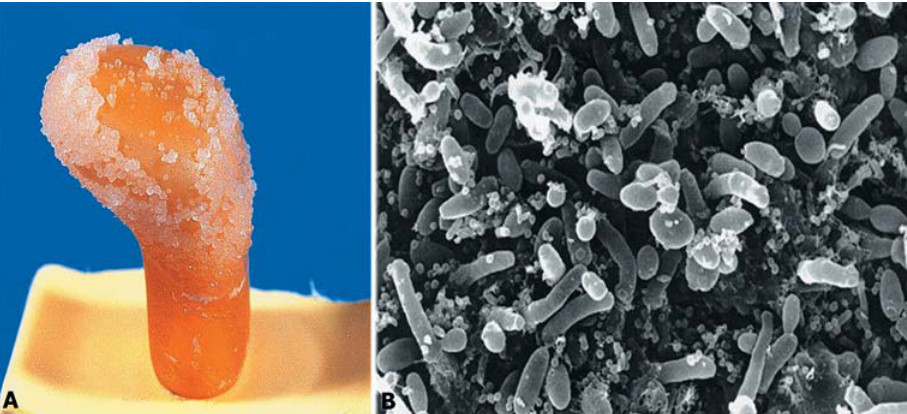
Figure 4- (cid:3)(cid:54)(cid:87)(cid:72)(cid:85)(cid:76)(cid:79)(cid:72)(cid:3)(cid:87)(cid:68)(cid:83)(cid:3)(cid:90)(cid:68)(cid:87)(cid:72)(cid:85)(cid:3)(cid:86)(cid:83)(cid:85)(cid:68)(cid:92)(cid:3)(cid:16)(cid:3)(cid:38)(cid:82)(cid:79)(cid:82)(cid:81)(cid:76)(cid:72)(cid:86)(cid:18)(cid:69)(cid:76)(cid:82)(cid:191)(cid:79)(cid:80)(cid:86)(cid:3)(cid:82)(cid:73)(cid:3) Mutans streptococci after microbial culture (A) and scanning electron microscopy micrograph